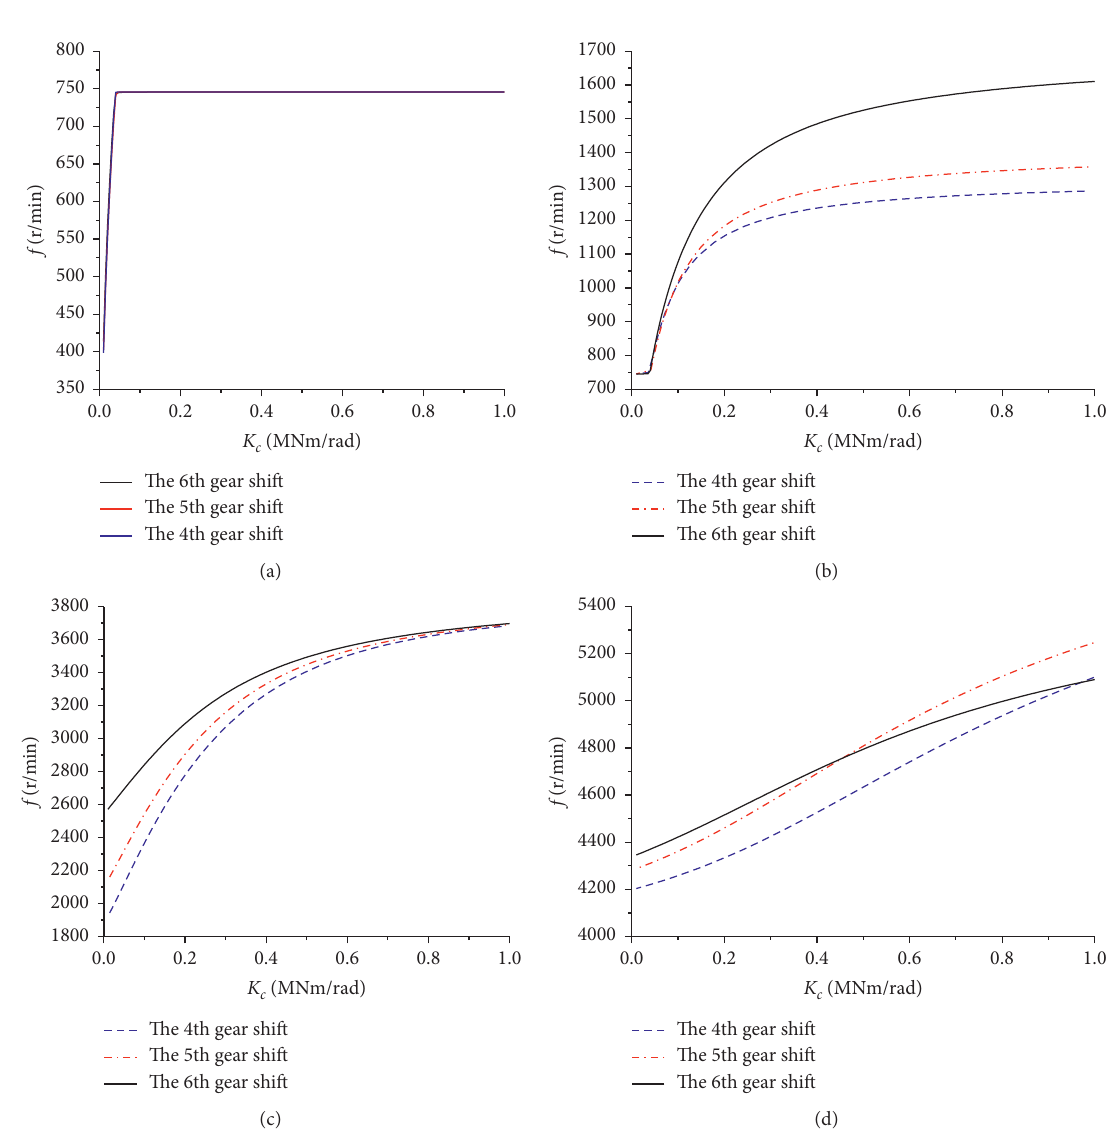
Figure 9: The effect of coupling stiffness on system natural frequency. (a) The 1st-order natural frequency. (b) The 2nd-order natural frequency. (c) The 3rd-order natural frequency. (d) The 4th-order natural frequency.